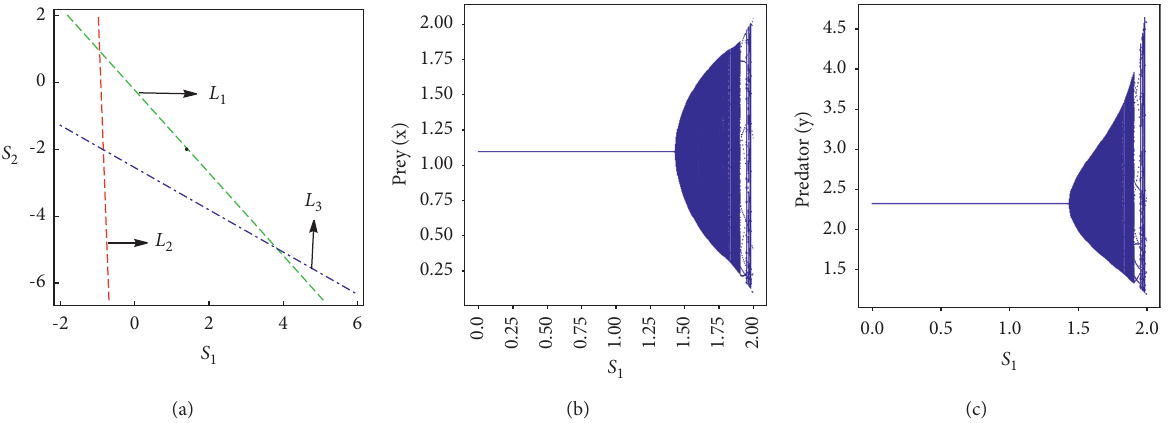
Figure 8: For the controlled system (48) with r E ∗ ( x ∗ ,y ∗ ) � ( 1 . 099589 , 2 . 329801 ) . (a) The stability triangle and ((b), (c) depict the bifurcation diagrams with s